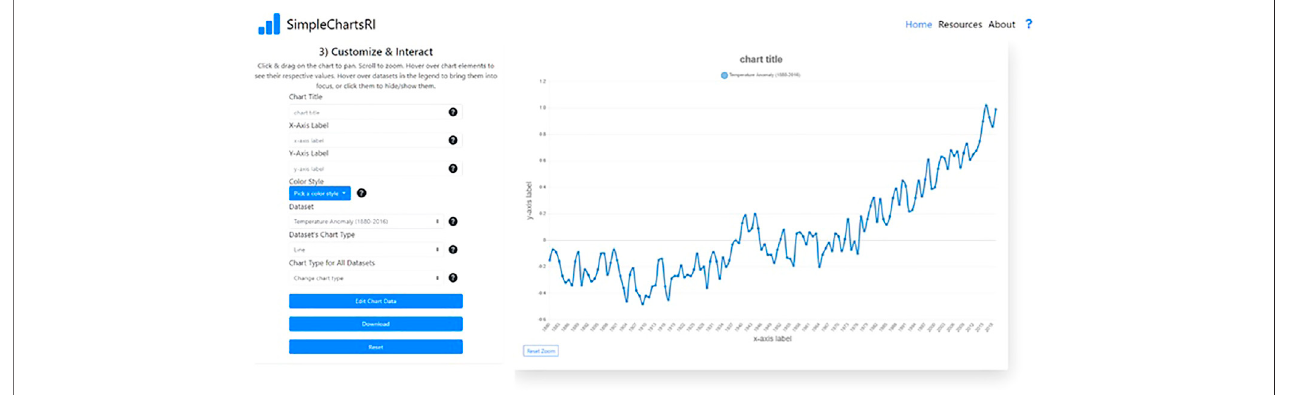
FIGURE 8 | simplechartsri.com highlighting feature of the customization and interaction page.